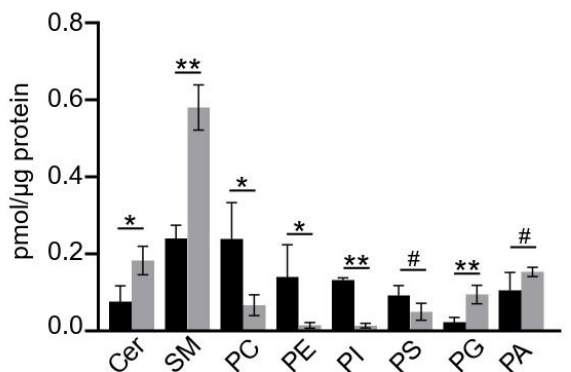
Figure 2. PON2 deficiency alters lipid composition of cultured podocytes. Cellular sphingo- and phospholipids content of PON2-deficient and -proficient murine podocytes was assessed by LC MS/MS. PON2-deficient podocytes (grey bars) contain more ceramide and sphingomyelin compared to the control (black bars) (ceramide: mean 0.183 pmol/ µ g protein; SD 0.037 vs. mean 0.076 pmol/ µ g protein; SD 0.042; * p < 0.05; sphingomyelin: mean 0.581 pmol/ µ g protein; SD 0.059 vs. mean 0.240 pmol/ µ g protein; SD 0.035; ** p < 0.01). Content of phosphatidylcholine, phosphatidylethanolamine, and phosphatidylinositol are markedly reduced in PON2-deficient podocytes (* p < 0.05; ** p < 0.01; # not significant).